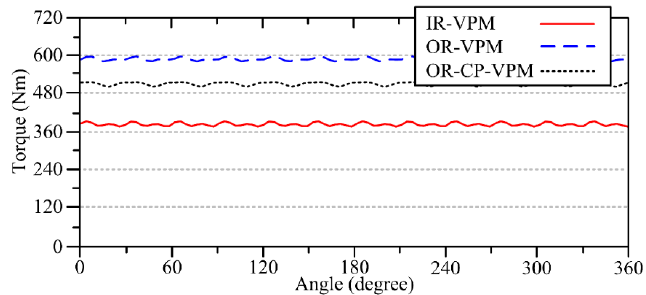
Figure 9. Steady torque waveforms.